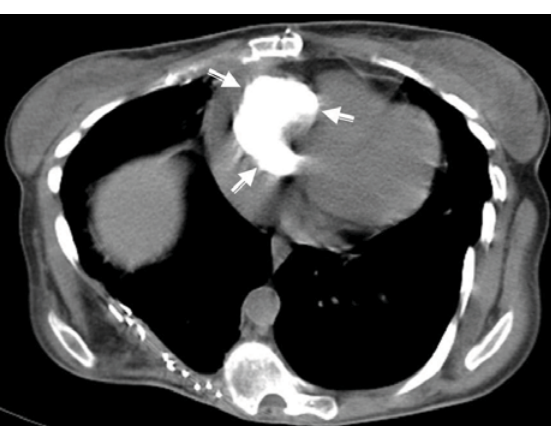
Figure 6. Axial non-enhanced thorax CT image clearly demonstrates the right paraaortic calcific mass in the pericardial space